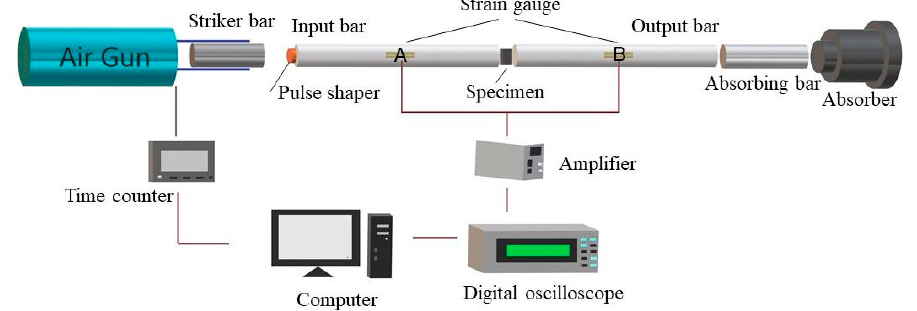
Figure 3. Schematic diagram of SHPB device.